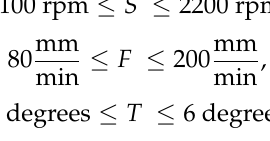
Table 10. Pareto ratio of the proposed